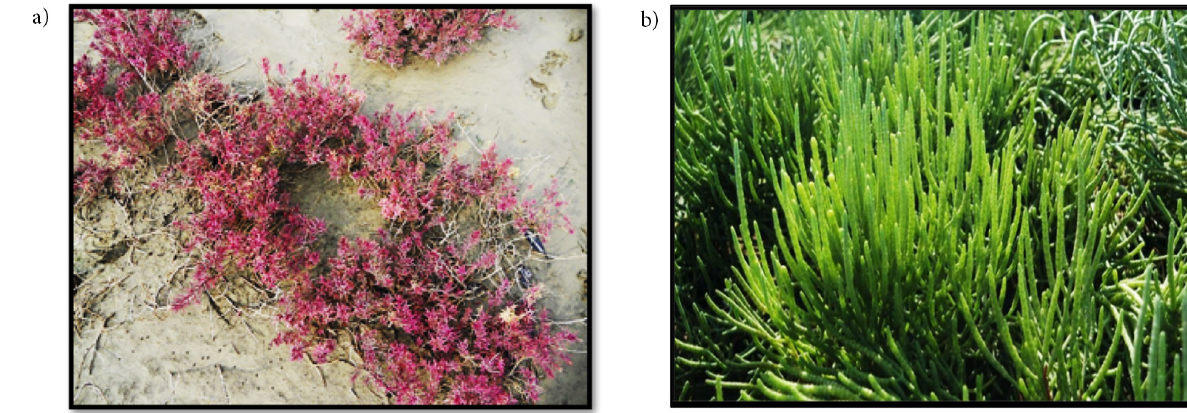
Figure 3. Representative images of the two thriving mangrove associate species growing in the high saline supralittoral zone of Indian Sundarbans: a) Suaeda maritima , a member of the Chenopodiaceae family; b) Salicornia brachiata , a member of the Amaranthaceae